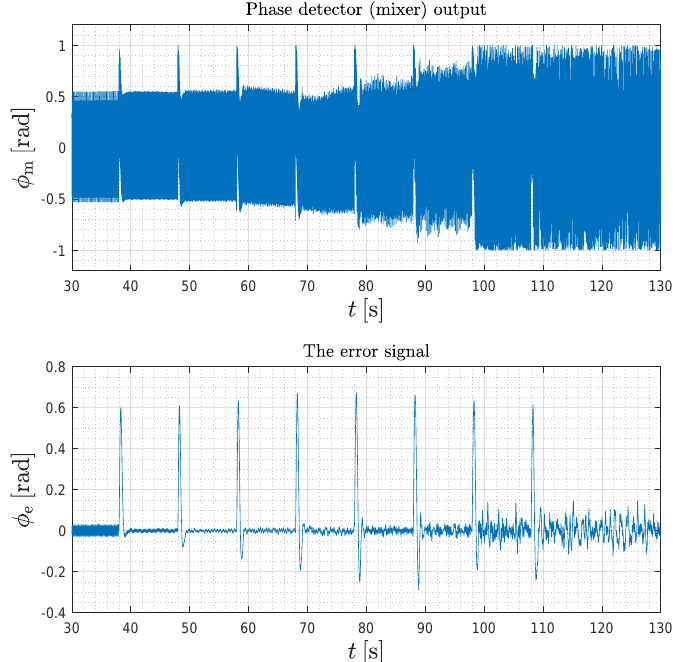
Figure 26. Measured step-up error response of the feedback